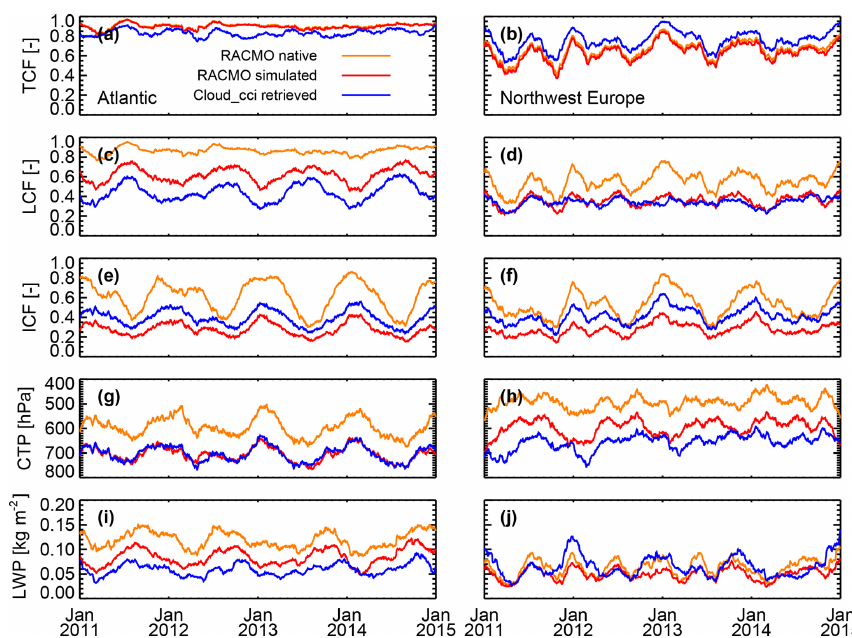
Figure 10. Time series of RACMO native model (orange), simulated (red), and Cloud_cci retrieved (blue) cloud properties for areas in the Atlantic (left; 48–53 ◦ N, 25–15 ◦ W) and northwest Europe (right; 48–53 ◦ N, 5–15 ◦ E) during 2011–2014: (a, b) total cloud fraction, (c, d) liquid cloud fraction, (e, f) ice cloud fraction, (g, h) CTP (hPa), and (i, j) LWP (kgm − 2 ). Shown are 2-month running means. All properties are all-sky linear averages, except CTP, which is an in-cloud logarithmic